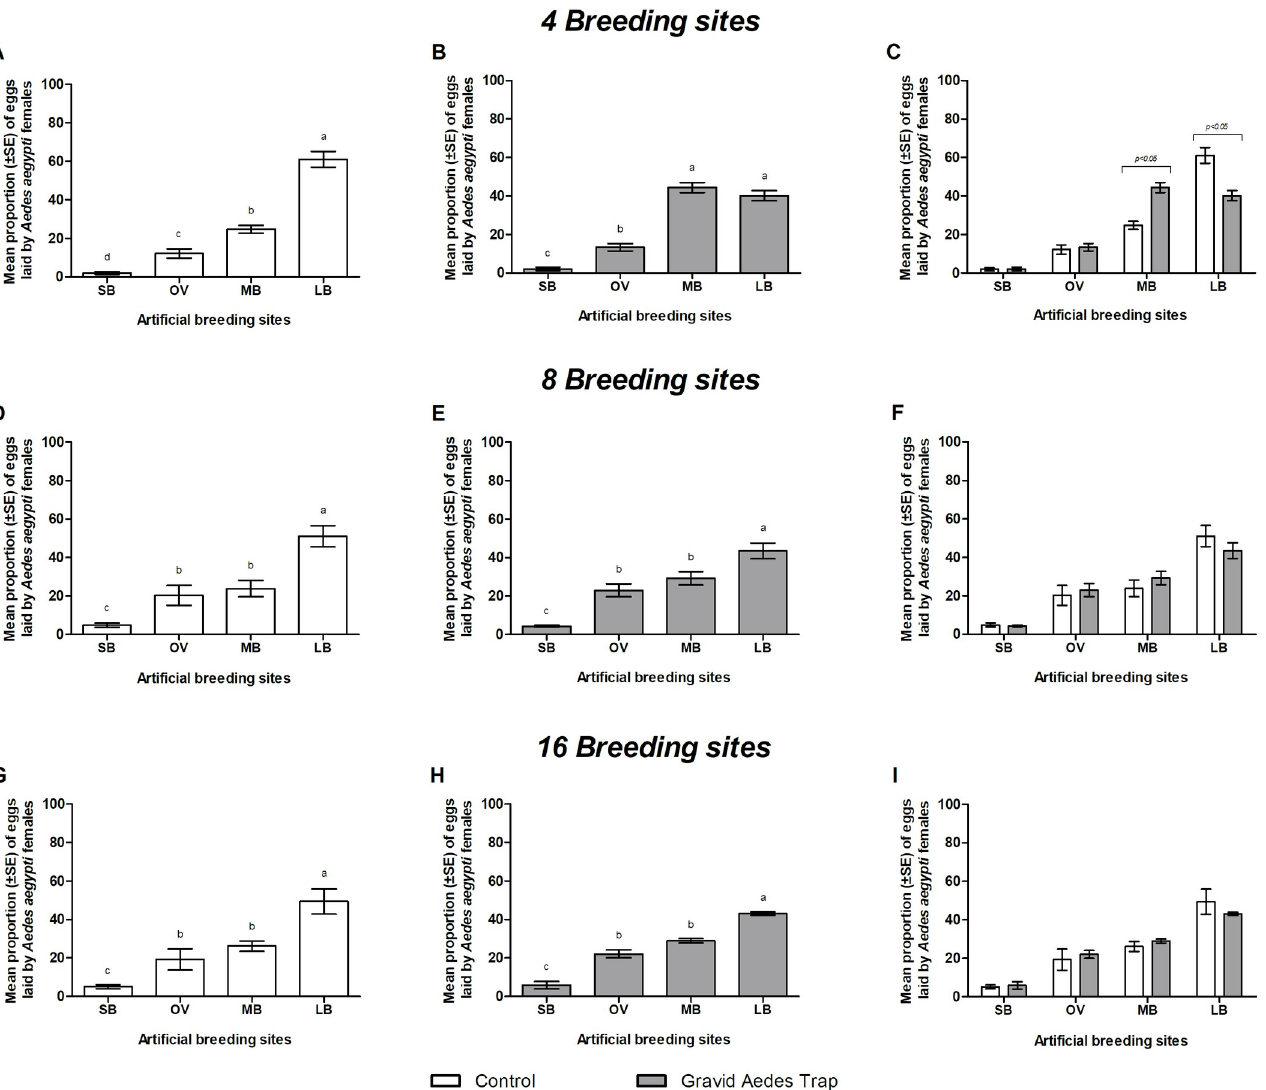
Fig 5. Mean percentage ( ± SE) of eggs laid by Aedes aegypti females in breeding sites with different dimensions in simulated outdoor environments with 4, 8 or 16 breeding sites and the presence (panels B, E and H) or absence (panels A, D and G) of the Gravid Aedes trap (GAT). Panels C, F and I shows the comparison among eggs laid in different breeding sites according to the environments with and without traps. SB: Small artificial breeding site (6.5 x 9 cm); OV: Regular size ovitrap (9 x 12.5 cm); MB: Medium artificial breeding site (20.5 x 20 cm); LB: Large artificial breeding site (28 x 26 cm). Different letters at the top of the columns in panels A-B, D-E and G-H indicate significant differences (p < 0.05). Horizontal lines on top of the bars in Panel C show the significant difference for MB with and without the BGS in the environment and for LB with and without the BGS